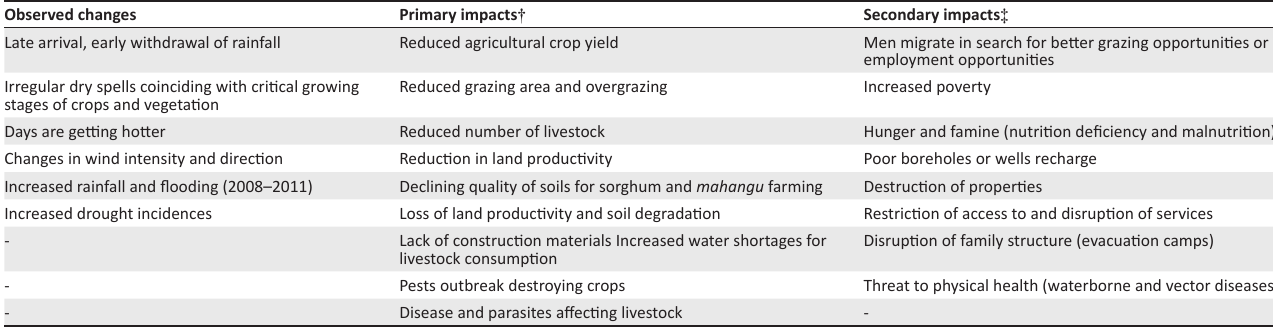
TABLE 3: Observed changes and impacts on subsistence agriculture. Observed changes